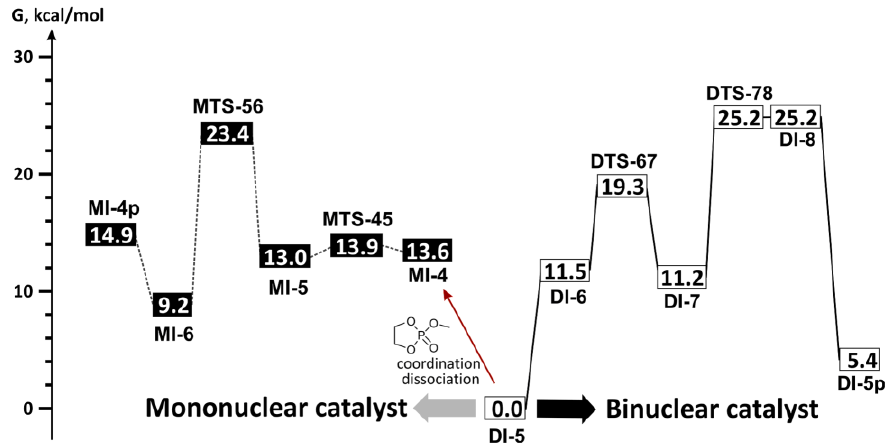
Figure 4. Energy profiles of BHT-Mg-catalyzed ROP of MeOEP for the mononuclear (---- dark gray, left) and binuclear ( — black, right) reaction mechanisms.